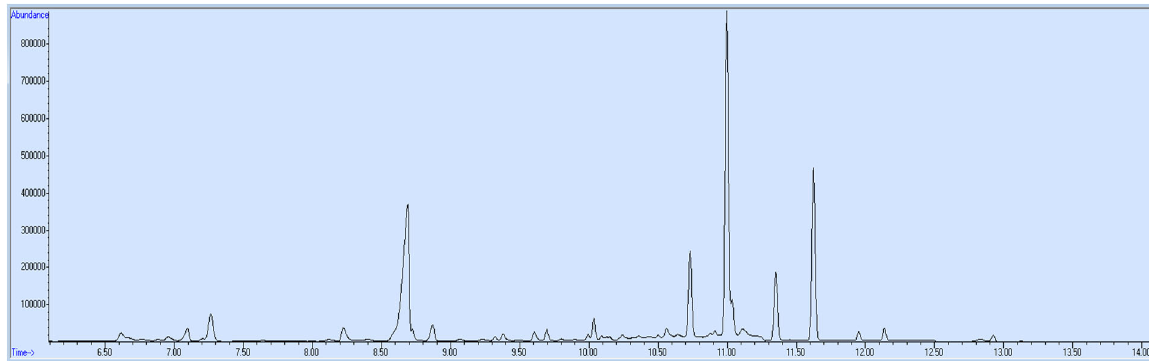
Figure 3. Urine sample—ion chromatogram.